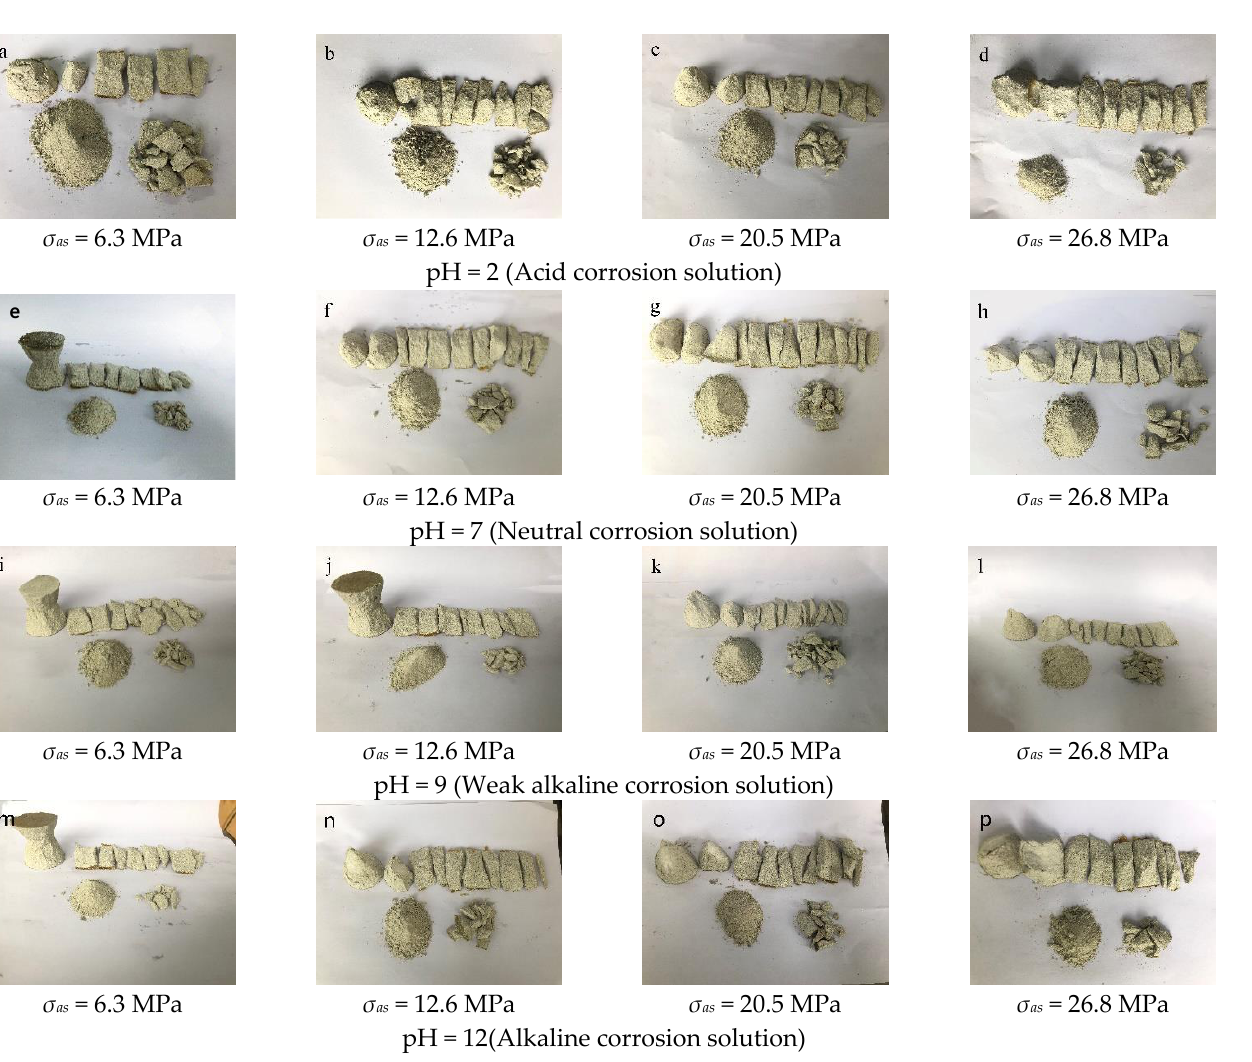
Figure 9. The destructed forms of white sandstone ( a – p